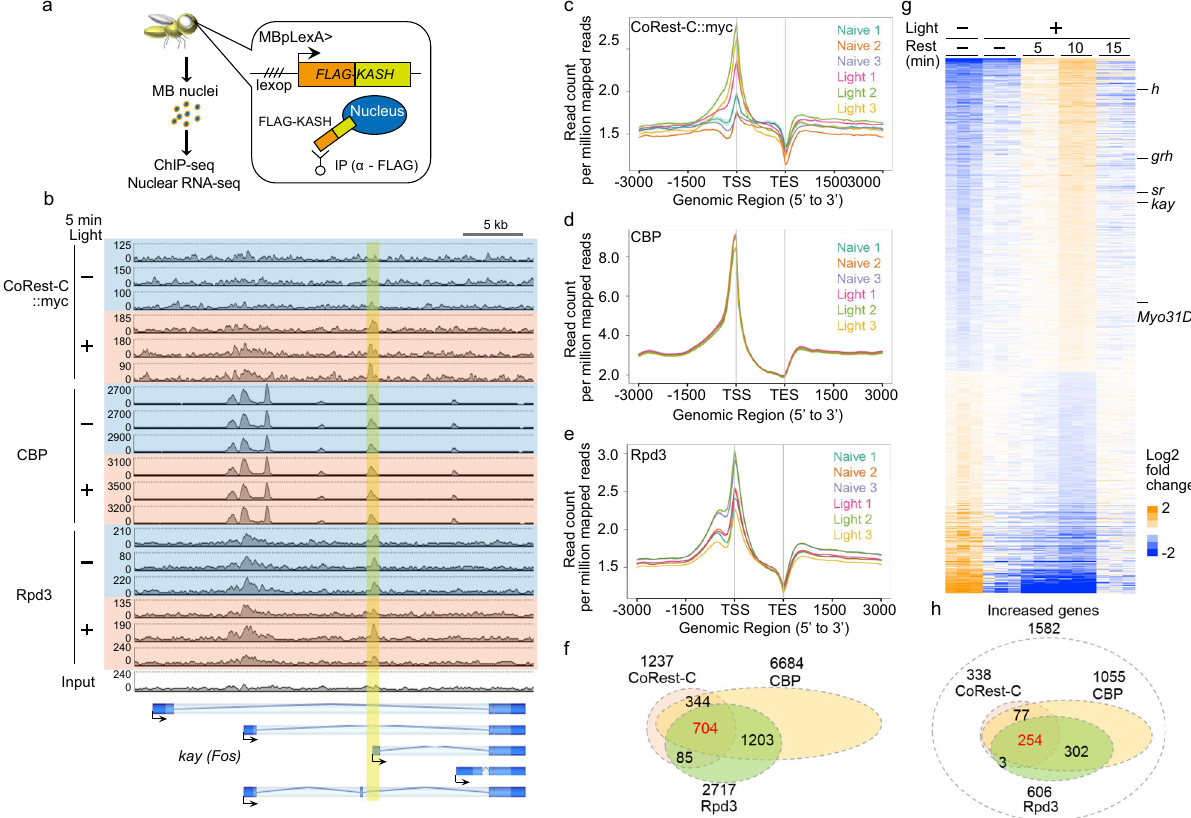
Fig. 6 CoRest-C, Rpd3, and CBP colocalize to the speci fi c gene loci. a Schematic diagram of the preparation of MB nuclei. The KASH domain, which is inserted to the outer membrane of the nuclear envelope, was tagged with FLAG, and expressed in MB neurons using the MBp-LexA driver 43 . The FLAG- labeled MB nuclei were collected by immunoprecipitation with the anti-FLAG antibody. b ChIP-seq signals at the region near kay . FLAG-KASH and CsChrimson were expressed by MBpLexA. CoRest-C::myc was expressed by MBsw. MB nuclei prepared from naïve fl ies or fl ies illuminated with red light were subjected to ChIP-seq analysis, using anti-myc ( n = 3), anti-CBP ( n = 3), or anti-Rpd3 ( n = 3) antibodies. The sequencing data of input DNA were shown at the bottom. Overlapped binding sites determined by peak calling are highlighted by a yellow vertical bar. The y axes show the number of mapped reads, and the upper limits were adjusted to the number of total reads in each sample. c – e Aggregate gene plot. The mapped reads of each sample were summarized with respect to the distance from the transcriptional start site (TSS) and the transcriptional end site (TES). f Venn diagram showing overlaps in CoRest-C-, CBP-, and Rpd3-binding sites. g Heatmap of the log2 fold change in expression of 2702 genes signi fi cantly altered after 5 min of optogenetic activation followed by 10 min of rest. Increased genes, 1582; decreased genes, 1120. h Venn diagram showing the overlap in CoRest-C-, CBP-, and Rpd3- binding sites in the 1582 genes showing increased expression in g